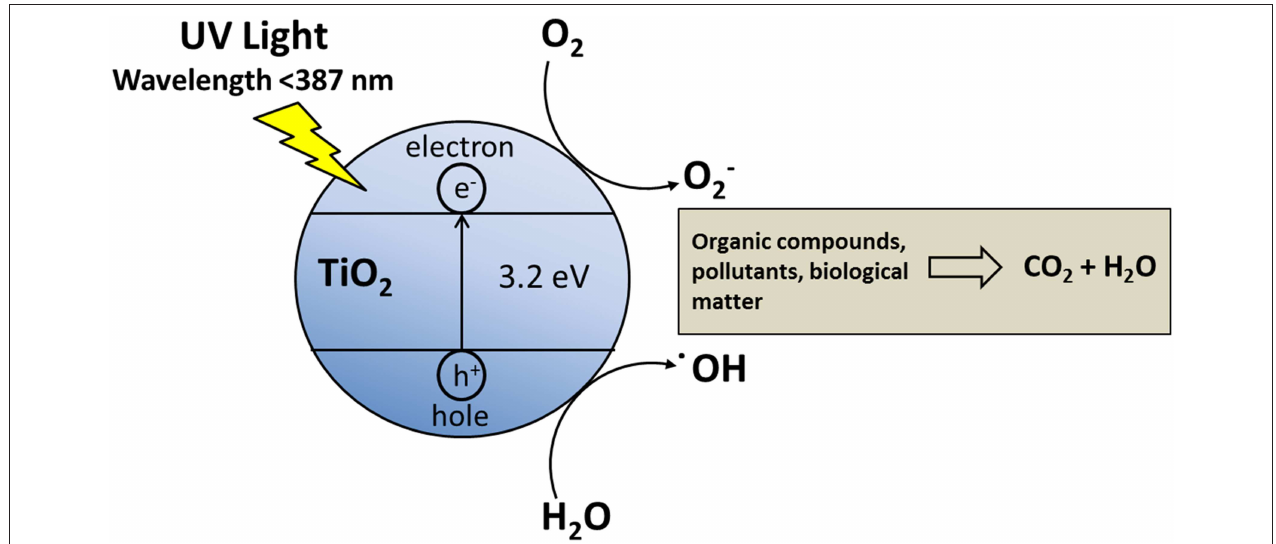
FIGURE 3 | Schematic representation of photocatalytic process of TiO 2